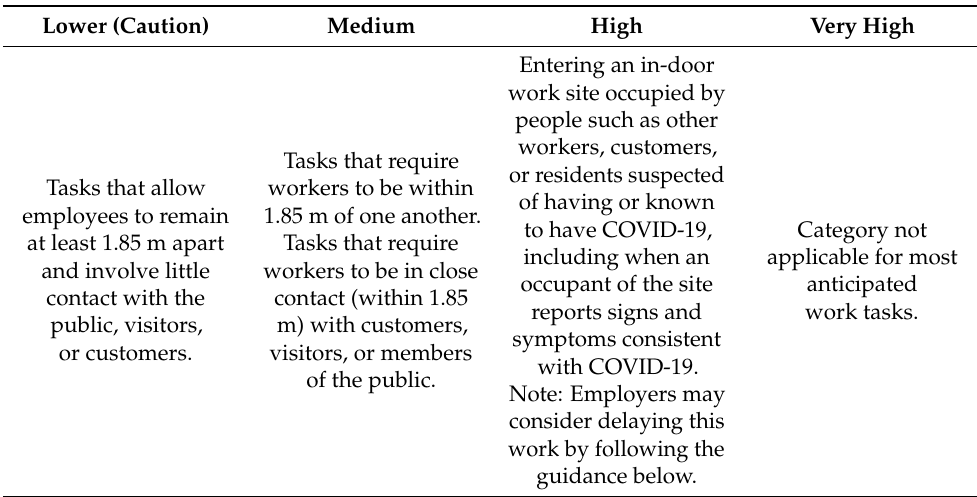
Table 2. Construction work tasks associated with exposure risk levels